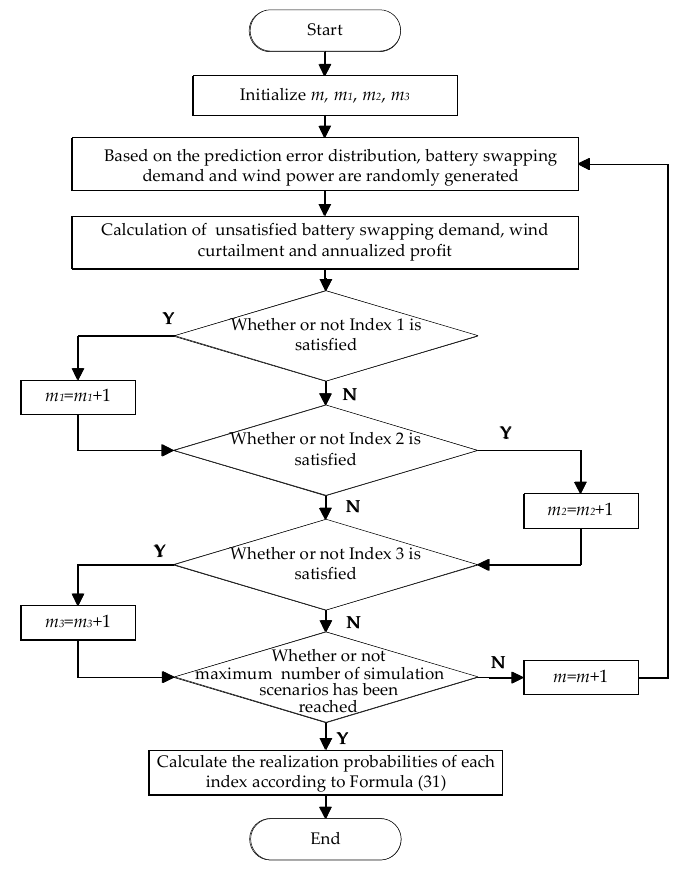
Figure 3. Flowchart of the Monte Carlo simulation.